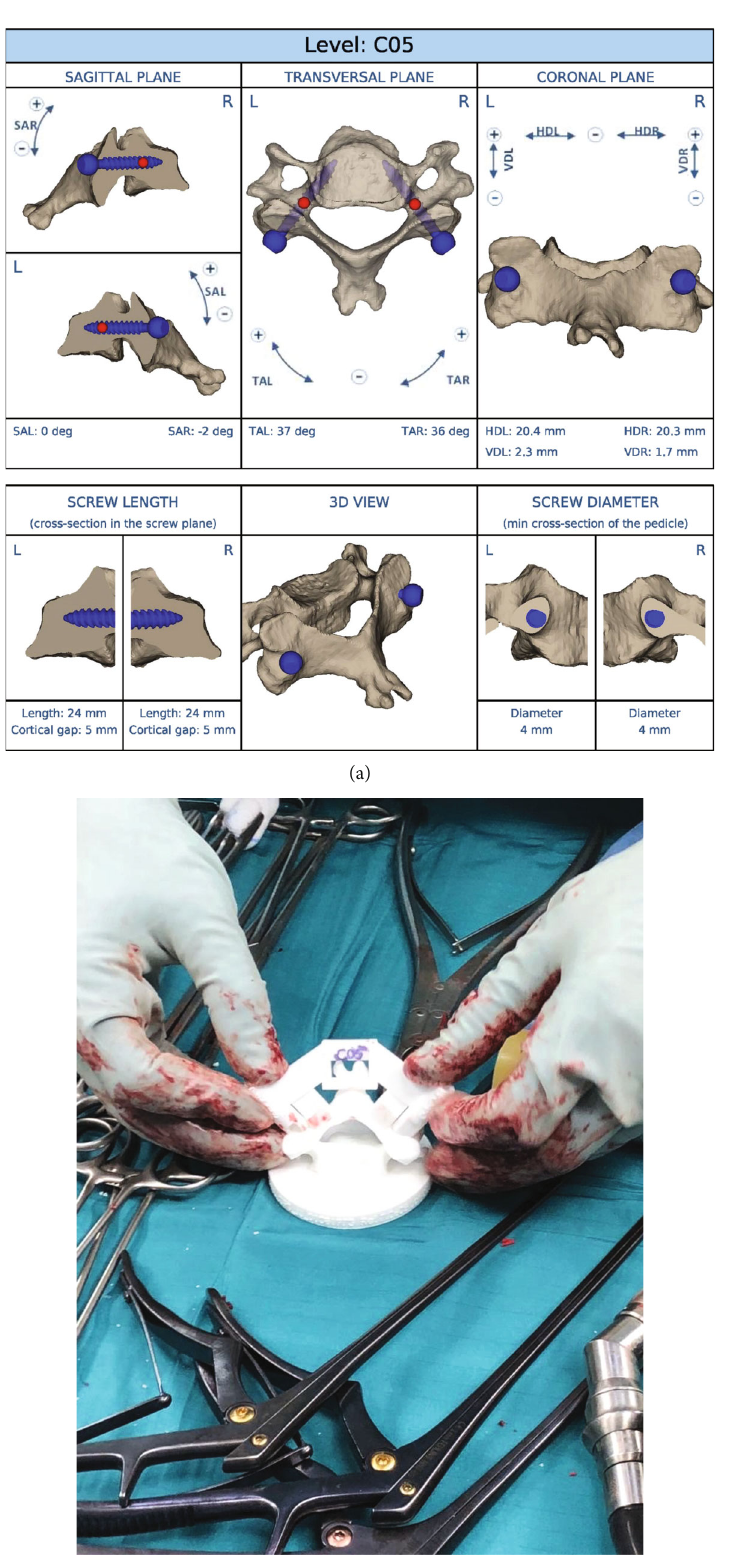
Figure 3: Drill guide templates. (a) Exemplary virtual presentation of the template provided by the manufacturer. This allows for meticulous planning of the entry point and the di ff erent screw parameters. (b) Shows the possibility to test the fi t between the drill guide and the corresponding vertebra ex situ